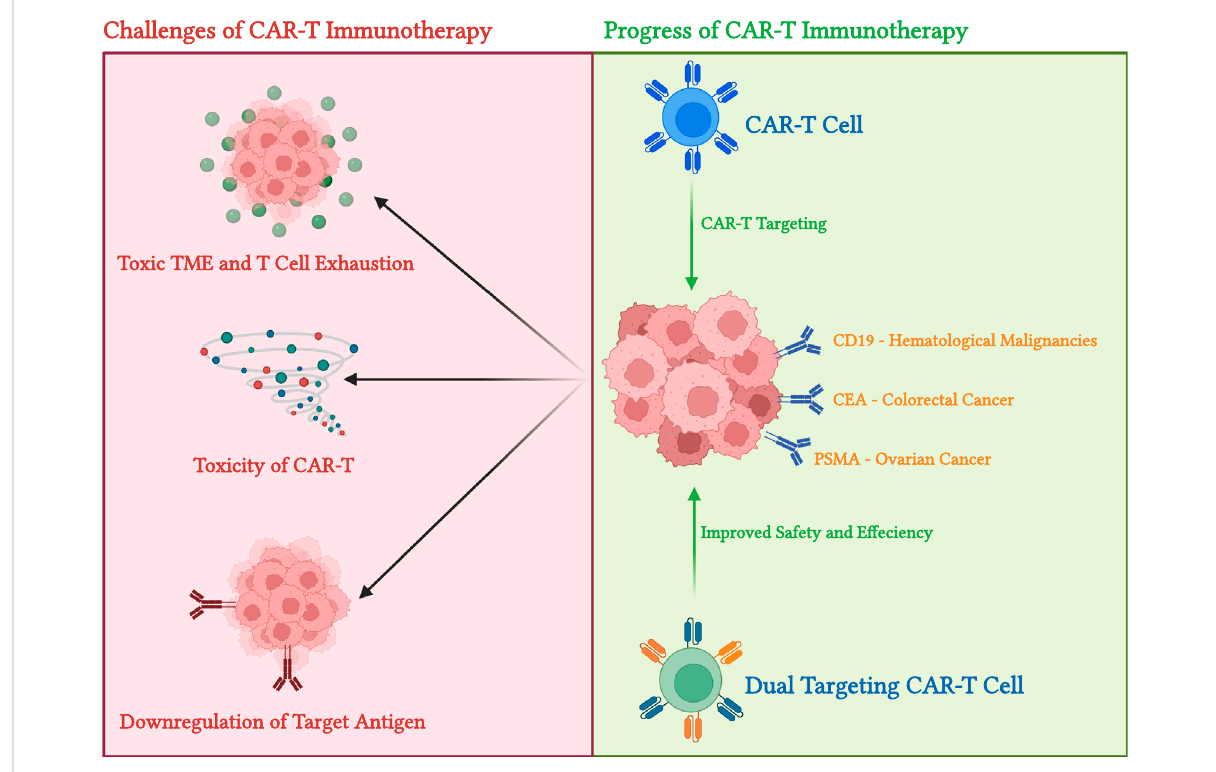
FIGURE 1 Evolution of CAR constructs. This diagram displayed the fi rst through fourth generations of CAR constructs attached to modi fi ed T cells. The diagrams display the compartments, antigen-binding site, and intracellular signalling domain and its components on either generation of CAR constructs. scFvs are marked red and green with the linker and hinge protein in purple. In addition, costimulatory domains inside the CAR-attached cells are combined with the CD3 ζ domain. The latest generation of CAR constructs produces molecules to modify DNA transcription and cytokine release. Diagram produced with